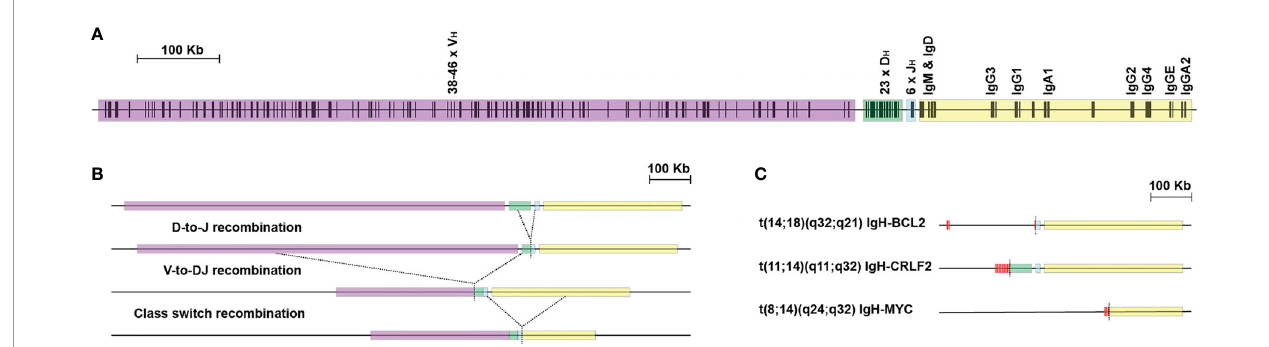
FIGURE 2 | Aberrent V(D)J & class switch recombination creates oncogenic translocations. Immunoglobulin variable region rearrangement and class switch recombination are error prone processes. (A) The immunoglobulin heavy chain locus is divided into different repetitive elements including variable segments (VH purple), diversity segments (DH green), joining segments (JH blue) and constant regions (yellow). Vertical bars depict both functional gene segments (typical numbers are indicated), non-functional pseudogenes (numbers not indicated) and repetitive elements (adapted from imgt.org). (B) Expression of recombinase activating genes (RAG) during pre pro, pro and pre B stages creates breaks between V(D)J segments, which are resolved by excision of intervening DNA. Activation induced cytidine deaminase (AID) deaminates cytosine residues of single stranded DNA which are exposed during transcription. The resulting mismatch is processed by error prone DNA repair mechanisms (including endonuclease G) resulting in excision of the default IgM/IgD constant region and fusion of the joining segments with constant regions of other isotypes. (C) Errors in resolving breaks initiated by RAG and AID can resolve as translocations with non-immunoglobulin loci. Break points adjacent to the heavy chain J H or D H segments indicate that translocations occur at the pre pro B cell stage in the bone marrow ( IgH/BCL2 or IgH/CRLF2 ). Similar translocations also originate from immunoglobulin light chain loci. Translocations may also result from class-switch recombination in the light zone of the germinal center, evidenced by breakpoints in the immunoglobulin constant region ( IgH/Myc ). Breakpoints adjacent to successfully rearranged V(D)J segments with somatically mutated variable portions indicate that an AID mediated translocation has occurred later in development in the germinal center dark